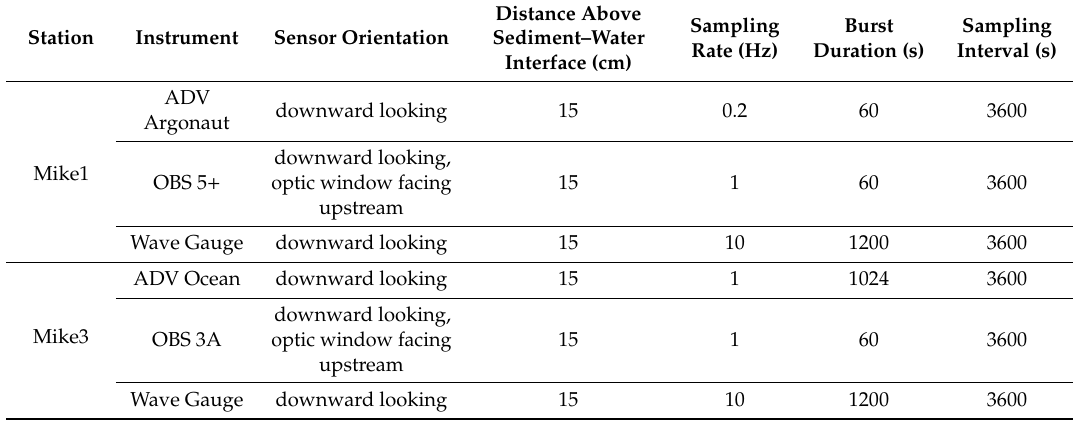
Table 1. Sampling specifications and placement of the instruments deployed at Mike1 and Mike3 during both field